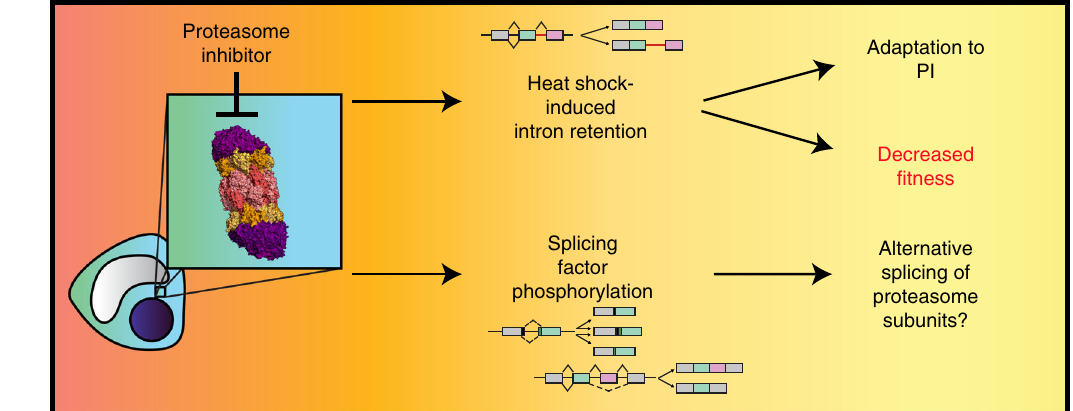
Fig. 5 Combined SRSF1 constructs validate the splicing phenotype after Cfz. a Histograms of Δ PSI in pooled analysis of parental AMO − 1-, SRSF1-WT-, SD-, and SA-expressing cells treated with 15 nM Cfz compared to DMSO. b Graph shows total number of events ( n = 62,474) for each ASE type (left panel) and only the signi fi cant (FDR-corrected p < 0.05) events ( n = 2,575) for each type (right panel). c Top ranked GO enrichment terms of all genes involved in signi fi cant ASEs, regardless of type. d RNA-seq coverage map (UCSC Genome Browser) compares counts for the proteasomal subunit PSMC5 between AMO-1 treated with 15 nM Cfz (bottom panel) and with DMSO (top panel). Inset displays sequencing counts showing alternative fi rst exon. e Model of new PI mechanism of action found in